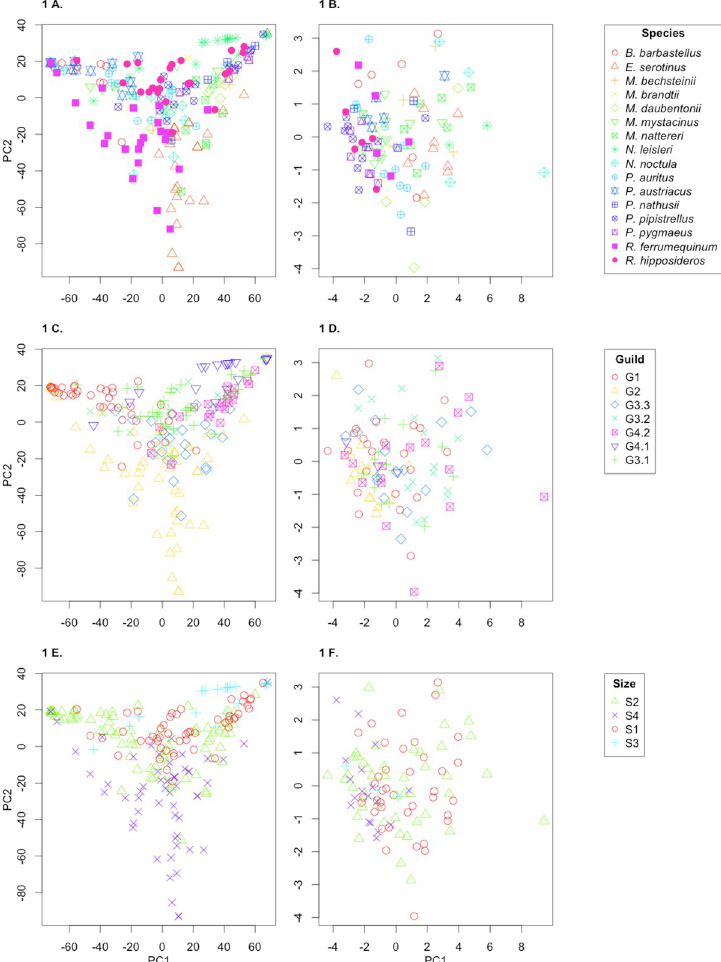
Fig 1. a-f. Principle component analysis plots of both diet (A, C, and E) and guano (B, D, and F) data. Data assigned by species (A,B), guild (C,D) and size